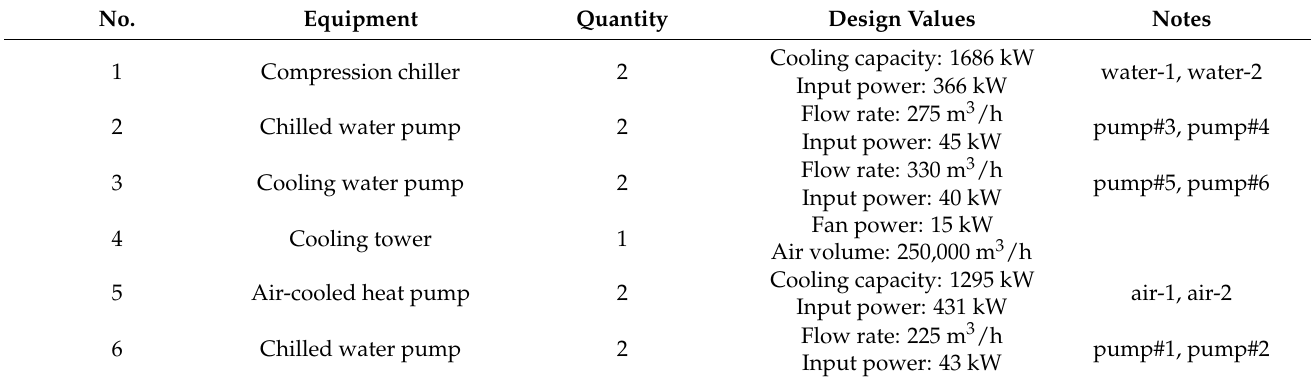
Table 1. List of parameters of equipment within the multi-chiller plant cooling system. No. Design